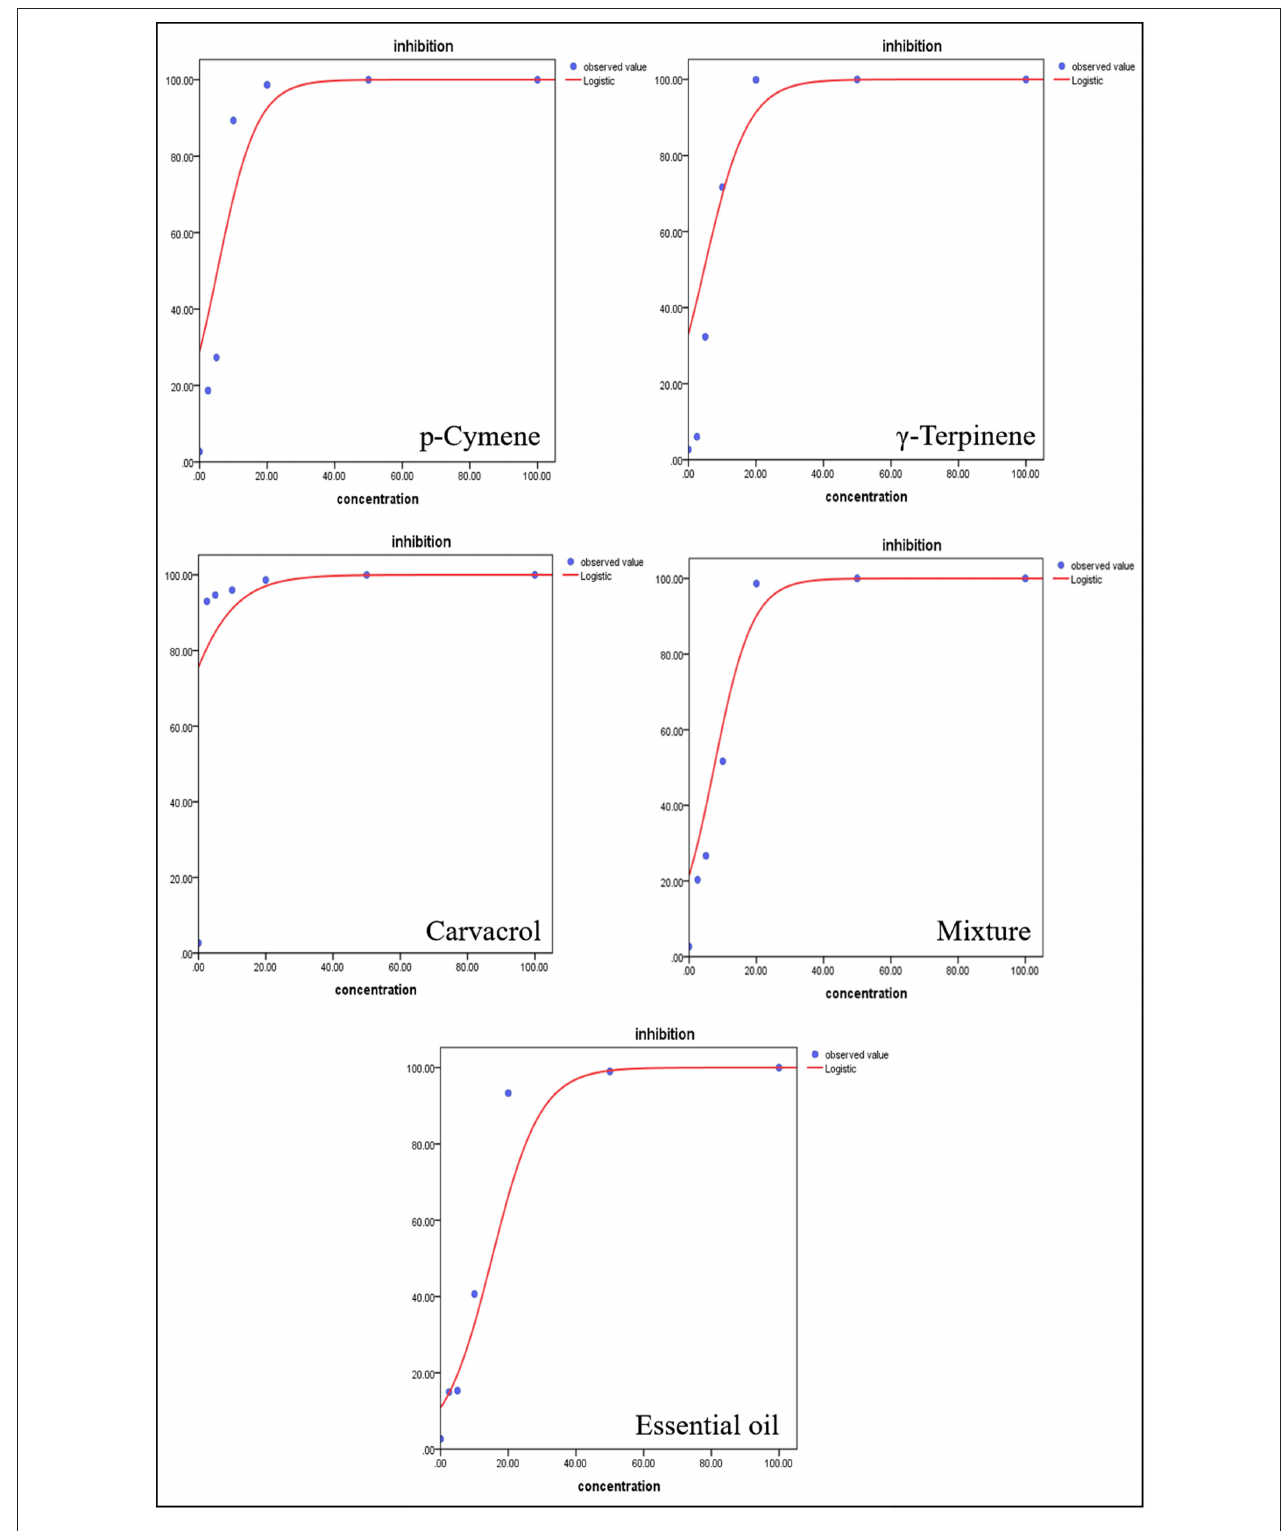
FIGURE 4 | Dose–response curves of Thymus proximus essential oil (EO) and its major constituents against Aphis gossypii adults.